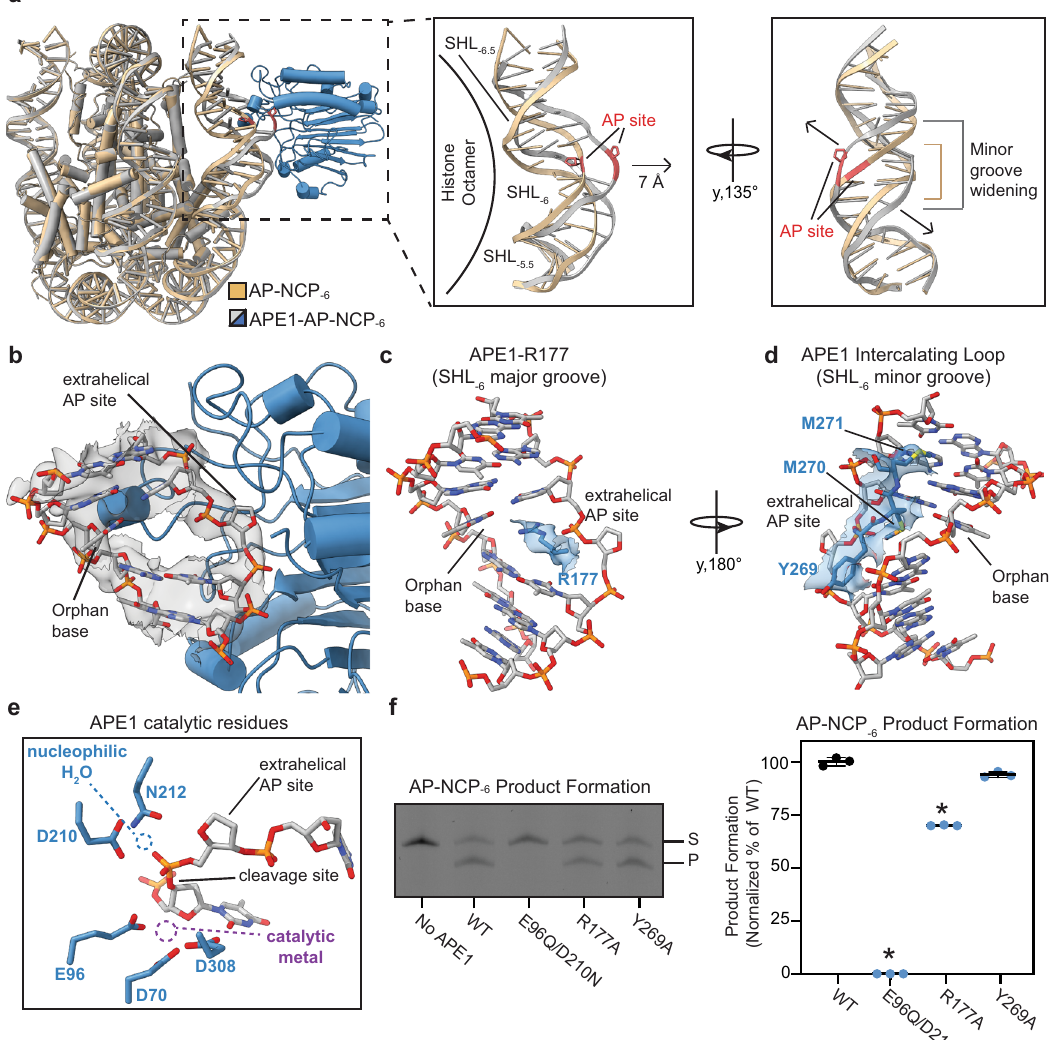
Fig. 4 | Mechanism of nucleosomal AP site recognition by APE1. a Structural overlay of the APE1-AP-NCP -6 complex and AP-NCP -6 . Focused view of the nucleo- somal DNAbetweenSHL − 5.5 and SHL − 6.5 without APE1shown highlighting changed in the nucleosomal DNA upon APE1 binding. b Focused nucleosomal DNA view of the AP site in the APE1 active site. The cryo-EM map is shown as a transparent gray surface. c Focused view of R177 in the APE1 active site at SHL − 6 . d Focused view of the APE1 intercalating loop at SHL -6 . The cryo-EM map is shown as a transparent blue surface for ( c and d ). e Focused view of and the nucleophilic water and metal coordinating residues in the APE1 active site. The nucleophilic water and metal